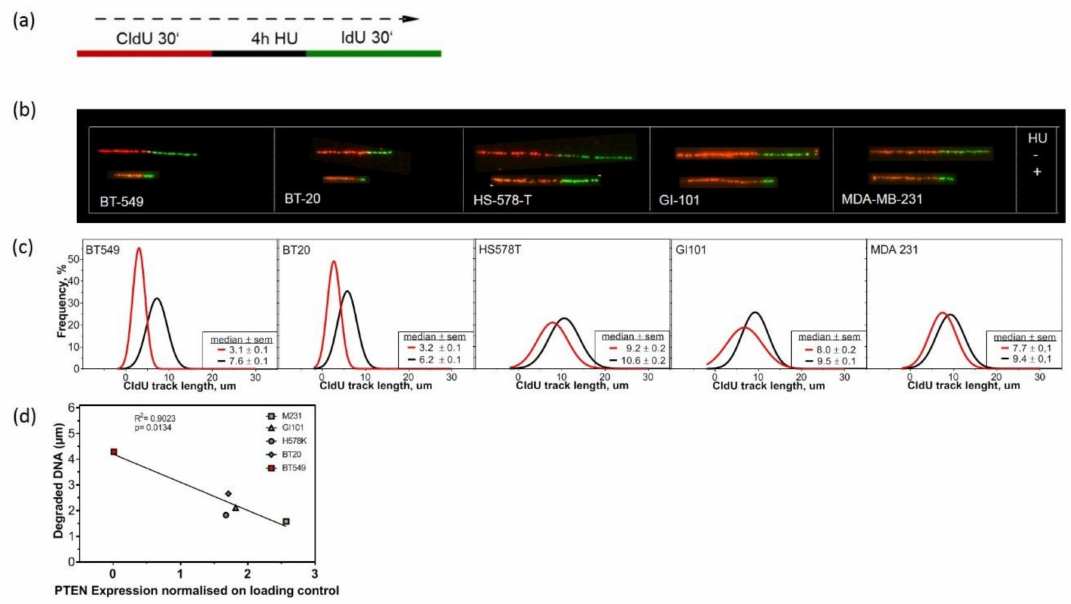
Figure 5. Fork instability after Hydroxyurea (HU) treatment in TNBC, dependent on PTEN expression. ( a ) Overview of DNA fiber assay labelling protocol. ( b ) Representative images of DNA fibers of 5 TNBC cell lines after treatment with 2 mM HU for four hours and untreated cells. Unstable replication fork indicated by shortening in CldU-labelled tract length in comparison to untreated controls. ( c ) Quantitative analysis of CldU elongation track length after treatment with 2 mM HU in comparison to untreated controls. (red: HU treatment, black: untreated) ( d ) CldU elongation length correlates negatively with PTEN expression measured at protein level (see Figure 1). Each value represents the mean of three independent experiments with the SEM